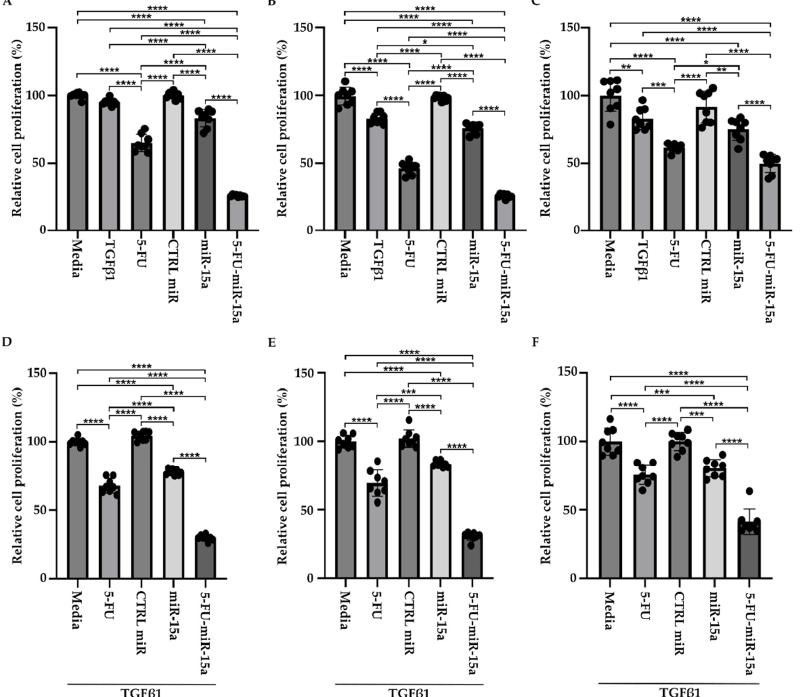
Figure 10 . 5-FU-miR-15a inhibits the growth of human pancreatic stellate cells as a single agent and in the context of TGF β 1 treatment. Human pancreatic stellate cells were treated with TGF β 1 and/or 5-FU, CTRL miR, miR-15a, and 5-FU-miR-15a, and cell viability was assessed at 144 h post-treat- ment. (A, D )—hPSCs obtained from Creative Bioarray, ( B , E )—hPSCs obtained from ScienCell, and ( C , F )—hPSCs obtained from CelProgen. Data are represented as the mean ± SD; N = 8 for single ( A – C ) and combinatorial ( D – F ) treatment. * p < 0.05, ** p < 0.01, *** p < 0.001, and **** p < 0.0001 by One- Way ANOVA.